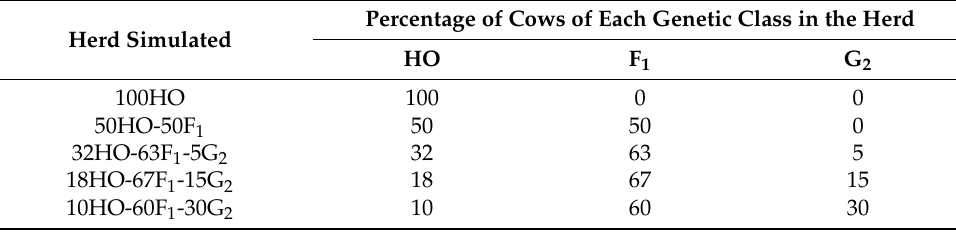
Table 4. Herd compositions (combinations of the three genetic classes HO, F 1 and G 2 ) simulated to estimate the economic performance at herd level. Percentage of Cows of Each Genetic Class in the Herd Herd Simulated HO F 1 G 2 100HO